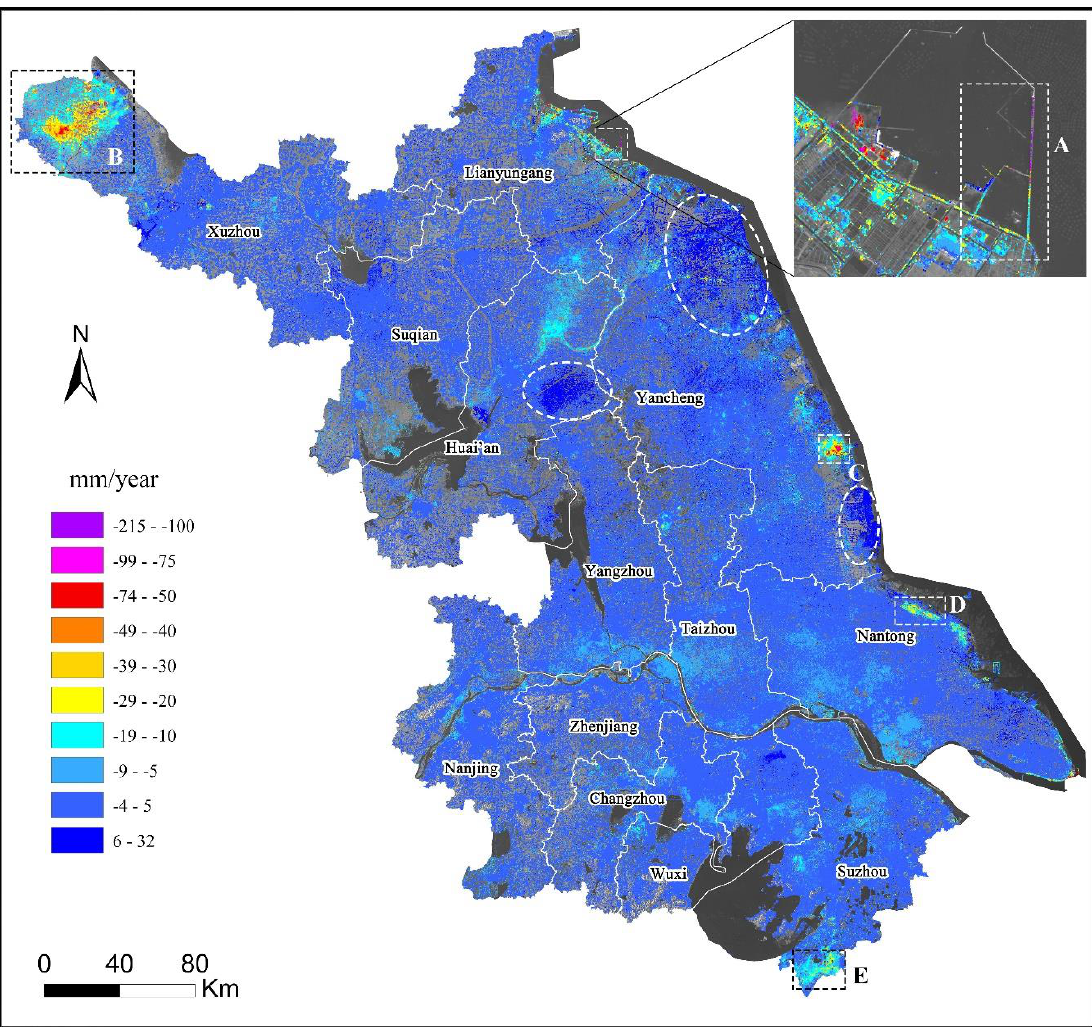
Figure 4. Geocoded mean subsidence velocity (MSV) mosaic of Jiangsu province calculated from S-1 images acquired between January 2016 and December 2018, where negative and positive velocities refer to ground subsidence and uplift respectively. The background is the averaged S-1 amplitude. White solid lines stand for the prefecture-level administrative boundaries. Five subsidence zones ( A – E ) with large subsidence velocity are marked out with dash-line rectangle and discussed in detail in Section 5. Three zones with ground uplift are marked out with dash-line